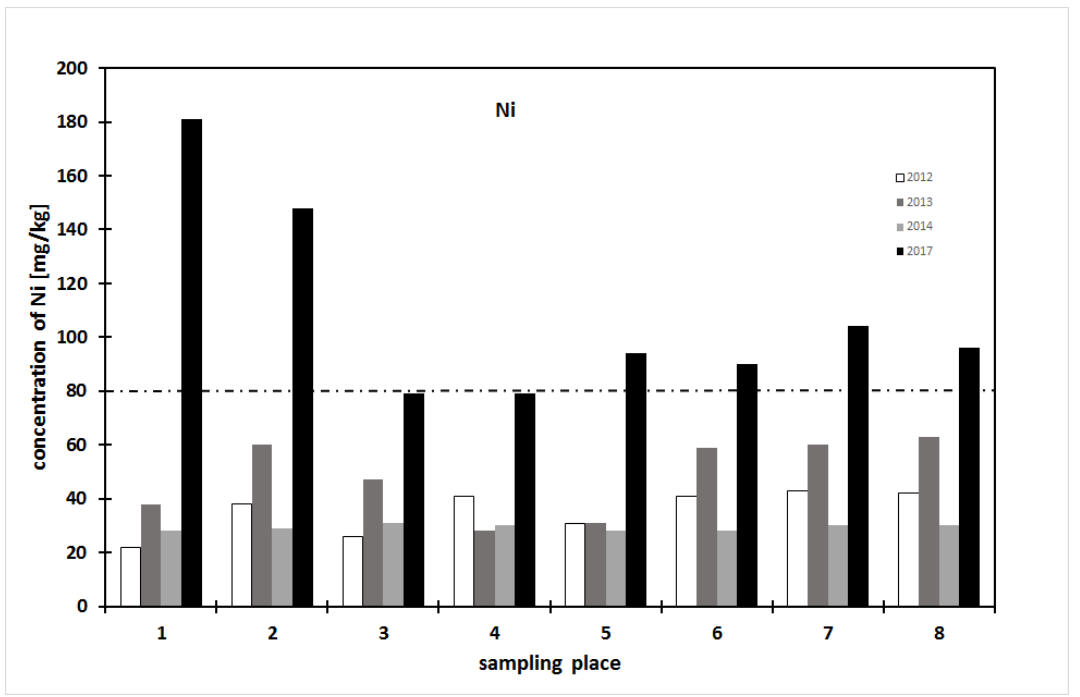
Figure 3. Content of Cu in sediments at individual sampling places in 2012, 2013, 2014, and 2017. The dashed line represents the limits for risk elements according to Annex No. 1 of the Czech Decree 257/2009 Coll. [30] . Limit of quantification <1 mg/kg.